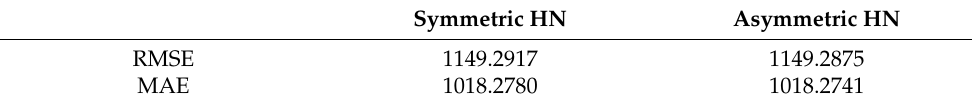
Table 7. June Performance